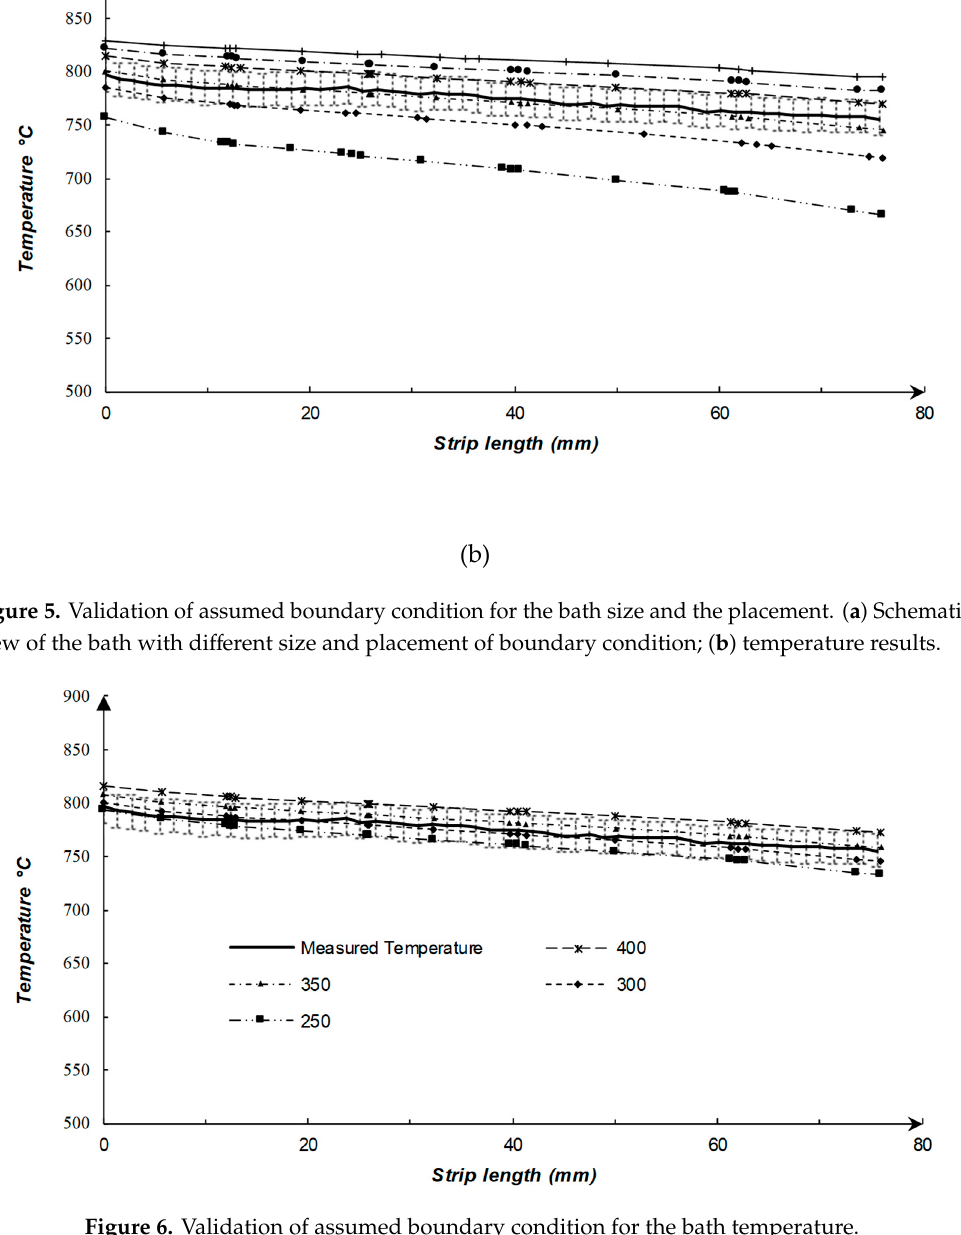
Figure 5. Validation of assumed boundary condition for the bath size and the placement. ( a ) Schematic view of the bath with different size and placement of boundary condition; ( b ) temperature results.